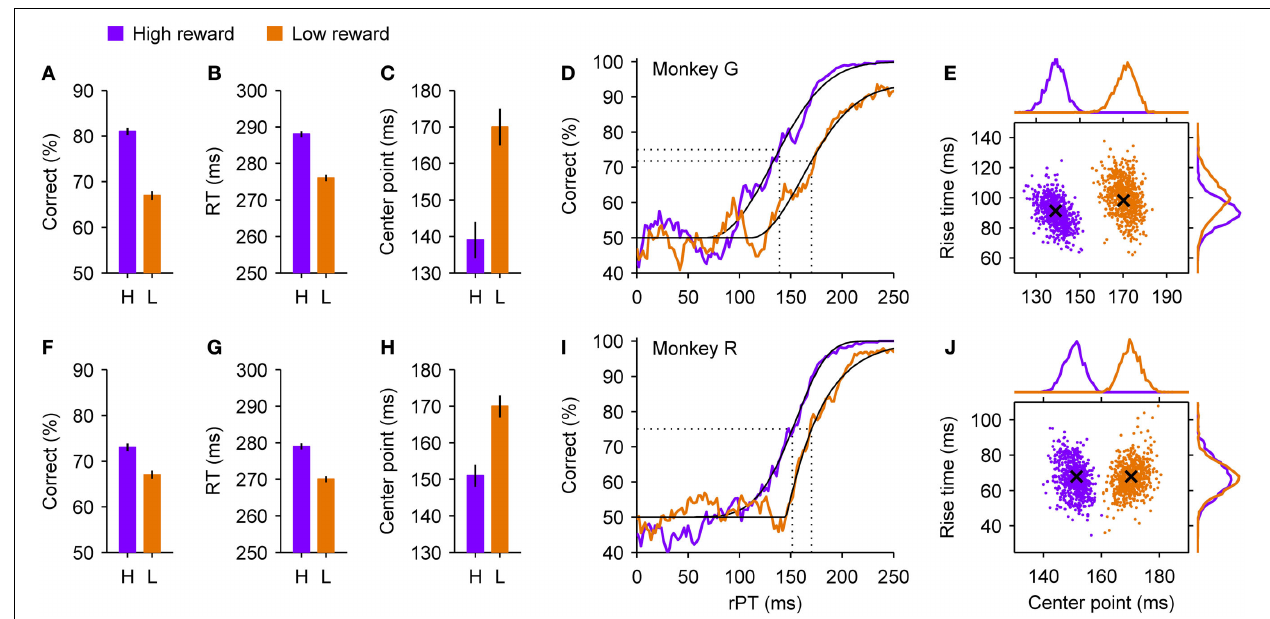
FIGURE 5 | Psychophysicalperformanceoftwomonkeysinamotivational bias experiment. Atthebeginning of eachtrialof thecompelled-saccade task, the monkey knew whether a correct response would result in a small or a large reward.Theshowndataweresorted posthoc accordingtotherewardthatwas at stake in each trial, as indicated. (A–C) Summary statistics for monkey G. Whenahighreward(purple)ratherthanalowreward(orange)wasatstake,the overall success rate (A) and mean RT (B) increased, and the tachometric curve shiftedtotheleft (C) ,indicatinganearlieronsetoftheperceptualdiscrimination. Error bars indicate ± 1 SE. (D) Tachometric curves from monkey G. Fitted Weibullfunctions(blackcurves)areshowntogetherwiththeexperimentaldata